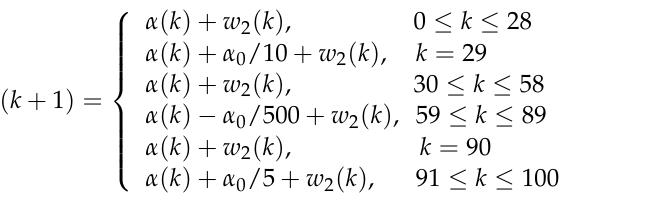
Simulation 2. Consider the following two-dimensional nonlinear system model: 1